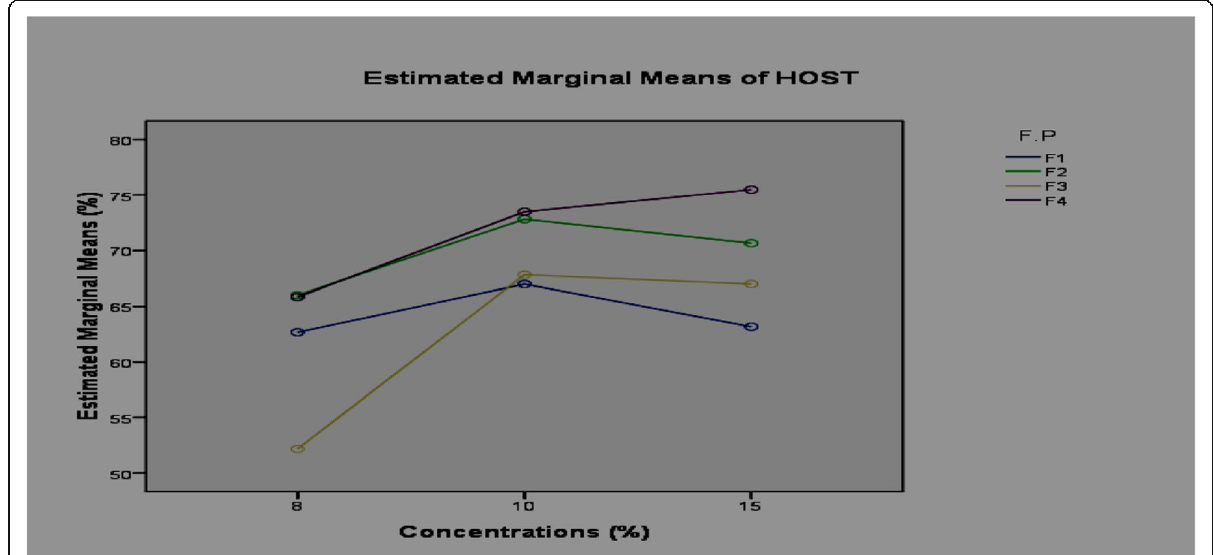
Fig. 4 Effect of different freezing protocols on hypo-osmotic swelling test of post thawed rooster semen on varying concentrations of